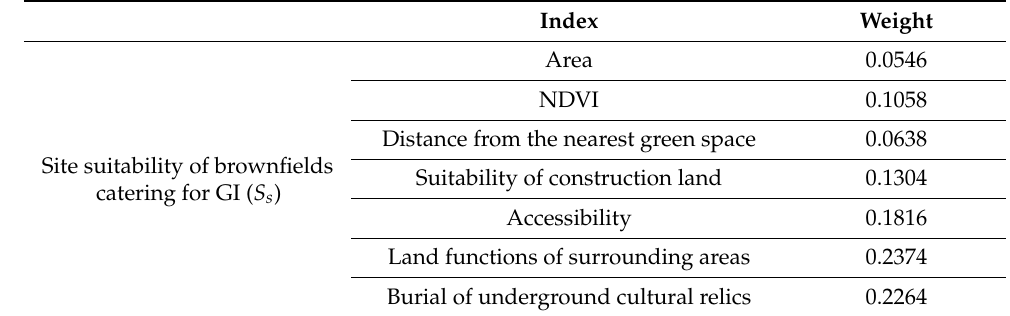
Table 5. Weights of site suitability indexes.